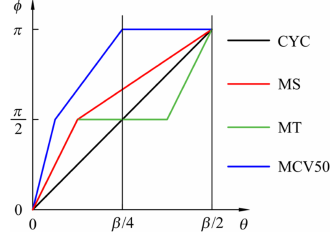
Figure 3. The four phase angle functions in trigonometric